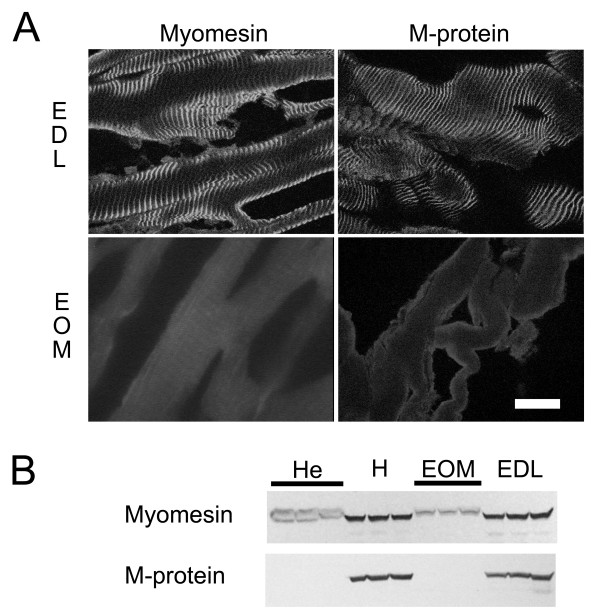
Myomesin and M-protein are downregulated in rat extraocular muscles. (A) Representative confocal micrographs showing that myomesin and M-protein are found in EDL muscle fibers (EDL, top) in the same stereotypical banding pattern, but are not detectable in extraocular muscle (EOM, bottom). Scale bar = 20 μm. (B) Western blots demonstrating the presence of myomesin and M-protein in EDL and heart (H). Embryonic heart (He) did not have M-protein, but two bands reacted with the myomesin antibody: myomesin and EH-myomesin, an alternatively spliced isoform of higher molecular weight. Extraocular muscle (EOM) contained EH-myomesin, but did not have detectable levels of myomesin or M-protein.